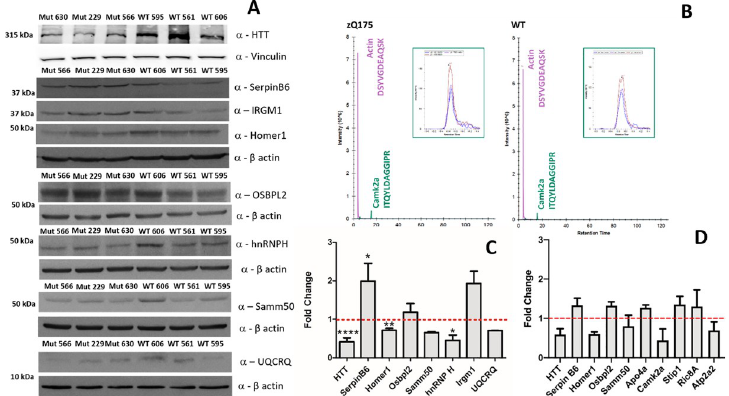
Fig 5. Validation of a selected group of proteins differentially expressed in WT and HD mouse model. (A) Western blot assays performed on total protein extracts from three mutant (zQ175(1), zQ175(2), zQ175(3)), and three wild-type (wt(1), wt(2), wt(3)) mice with antibodies against the selected proteins. β -actin was used for normalization. (B) MRM superimposed traces of transitions of one of CAMK2A proteotypic peptide reported for zQ175 (left panel) and WT (right panel) together with one ACTIN peptide transition. (C) Densitometric analysis of data from the western blot of panel A. The indicated values in the graph represent the percentage of arbitrary units compared to WT to which 100% was assigned. Results are represented as the as mean ± SD (standard deviation). The statistical significance was evaluated by parametric (Welch’s) or non-parametric (Mann-Whitney) tests when data failed the Shapiro–Wilk normality test. � p < 0.05, �� p < 0.01 ��� p < 0.001, ���� p < 0.0001. (D) Fold Change measured by MRM analysis of pooled HD and WT samples,